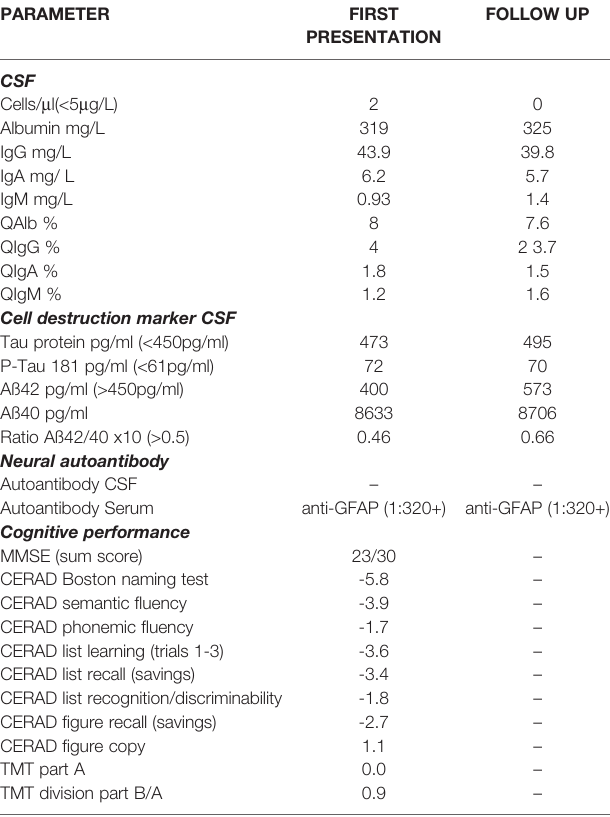
TABLE 1 | Laboratory assessment and cognitive data.